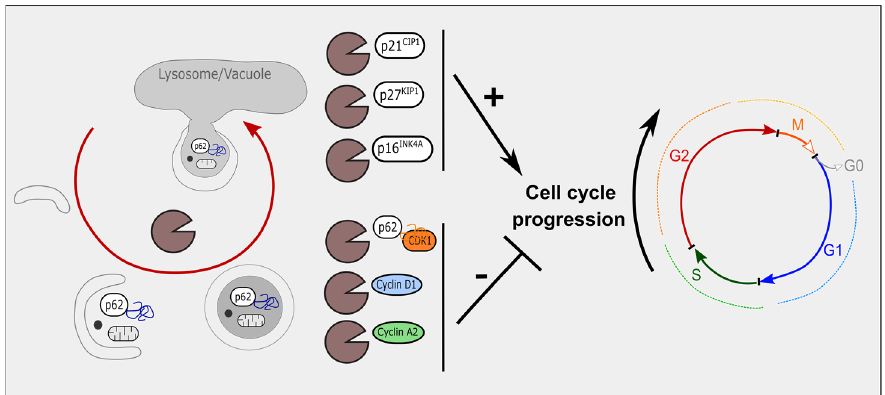
Figure 3. Cell-cycle regulators are targets of autophagy. p21 CIP1 , p27 KIP1 and p16 INK4A are among the three CKIs targeted by autophagy, their degradation ultimately leading to the progression of the cell cycle. Cyclins and CDKs are also degraded by autophagy. CDK1 binds to p62. Cyclin D1 and cyclin A2 are degraded by macroautophagy. Altogether, degradation of CDKs and cyclins block cell-cycle progression.